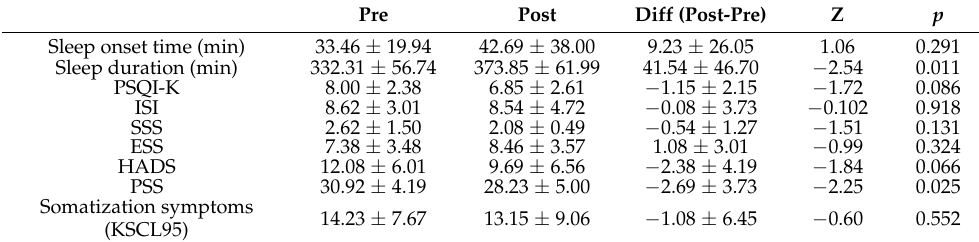
Table 3. Changes of the psychological variables of the participants (N = 13).